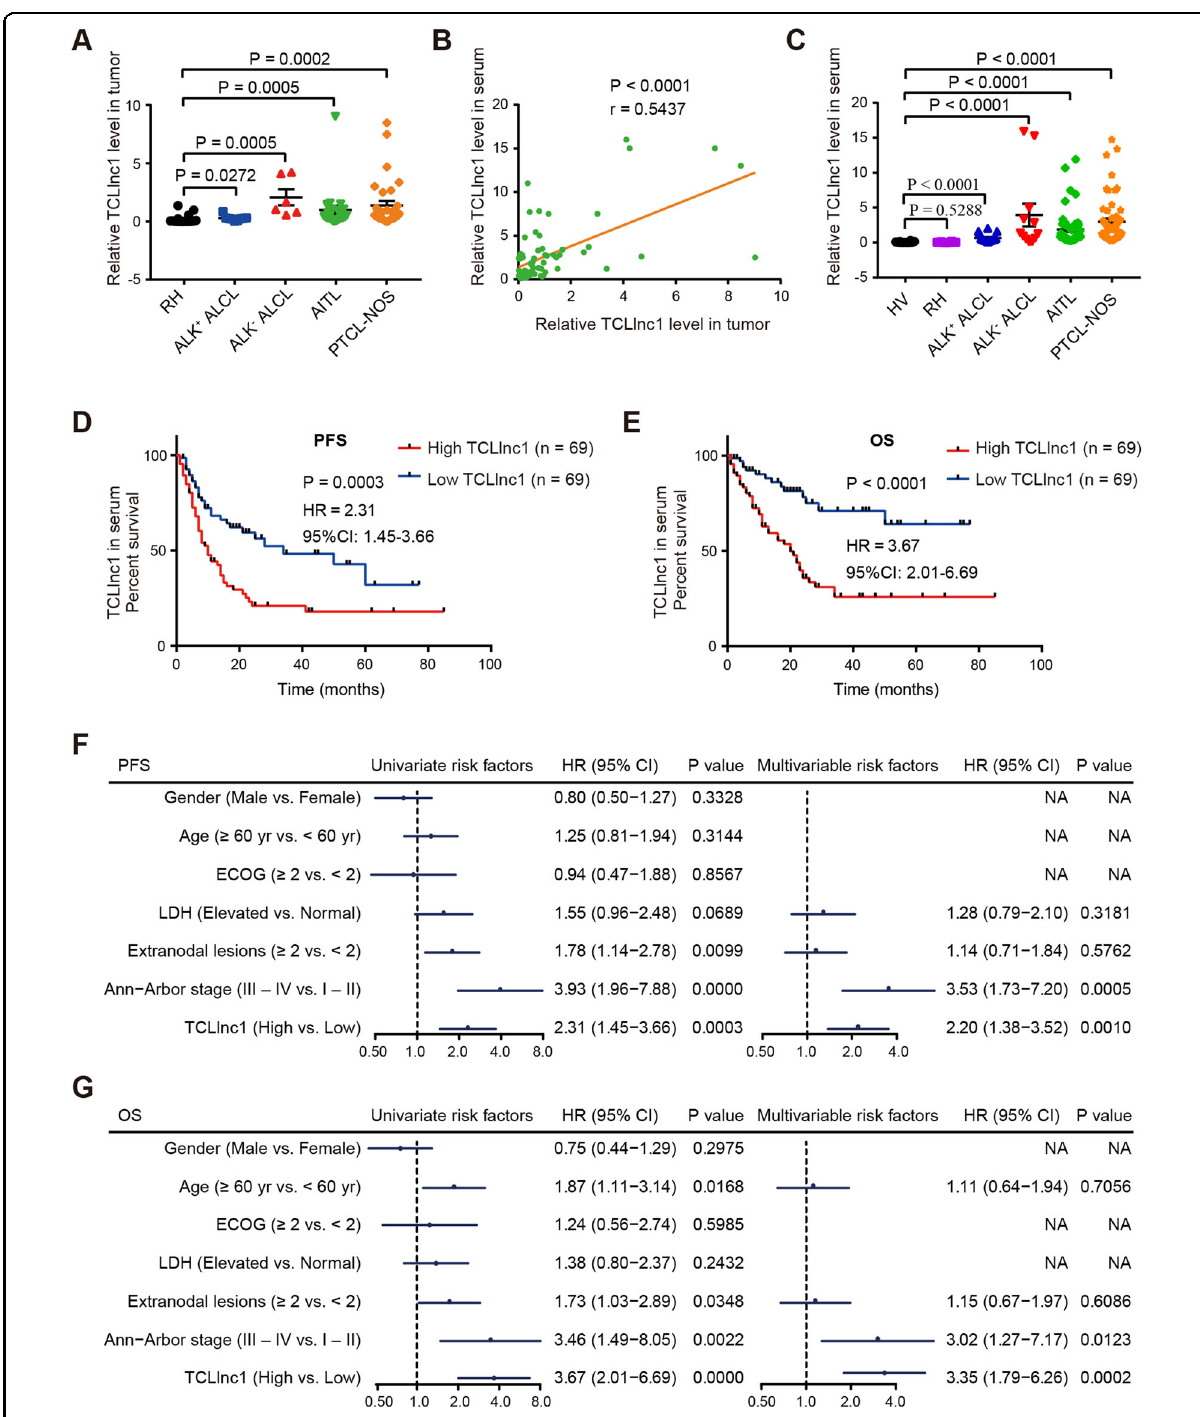
Fig. 2 TCLlnc1 was clinically relevant in PTCL. A Expression of TCLlnc1 in tumors of anaplastic large-cell lymphoma (ALCL)-anaplastic lymphoma kinase (ALK)-positive (ALK + ALCL, n = 9), ALCL-ALK negative (ALK − ALCL, n = 6), angioimmunoblastic T cell lymphoma (AITL, n = 23), and peripheral T cell lymphoma-not otherwise speci fi ed (PTCL-NOS, n = 32), as compared to RH ( n = 16) by quantitative real-time polymerase chain reaction (qRT- PCR). B Correlation between TCLlnc1 expression in tumor and in serum of PTCL patients ( n = 70). C Expression of TCLlnc1 in serum of RH ( n = 10), ALK + ALCL ( n = 18), ALK − ALCL ( n = 12), AITL ( n = 53), and PTCL-NOS ( n = 55) in comparison with healthy volunteers (HV, n = 10). TCLlnc1 expression was quanti fi ed by qRT-PCR. D , E Progression-free survival (PFS, D ) and overall survival (OS, E ) of PTCL patients according to TCLlnc1 expression in serum ( n = 138). F , G Univariate and multivariate analysis for PFS ( F ) and OS ( G ) in PTCL ( n =